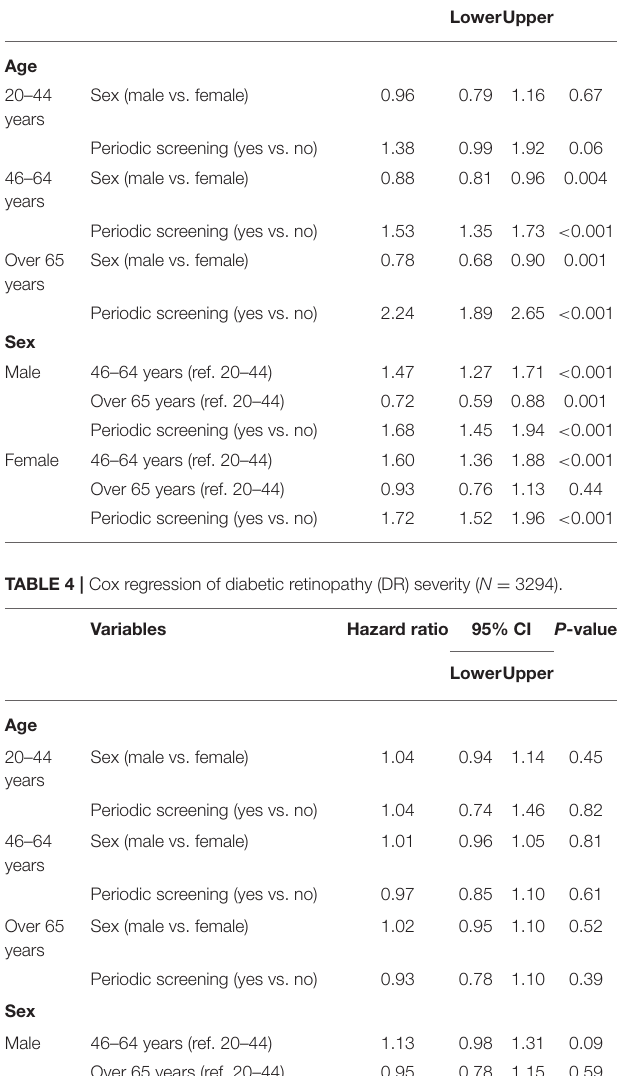
TABLE 3 | The correlations between Diabetic retinopathy (DR) treatments and variables related to the incidence. Variables